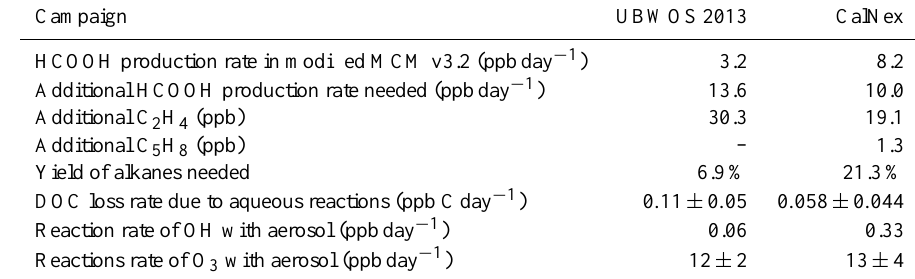
Table 3. Production rates of formic acid in the modified MCM v3.2 and the gaps between the box model simulations and measurements, and the reaction rates of aerosol-related reactions.